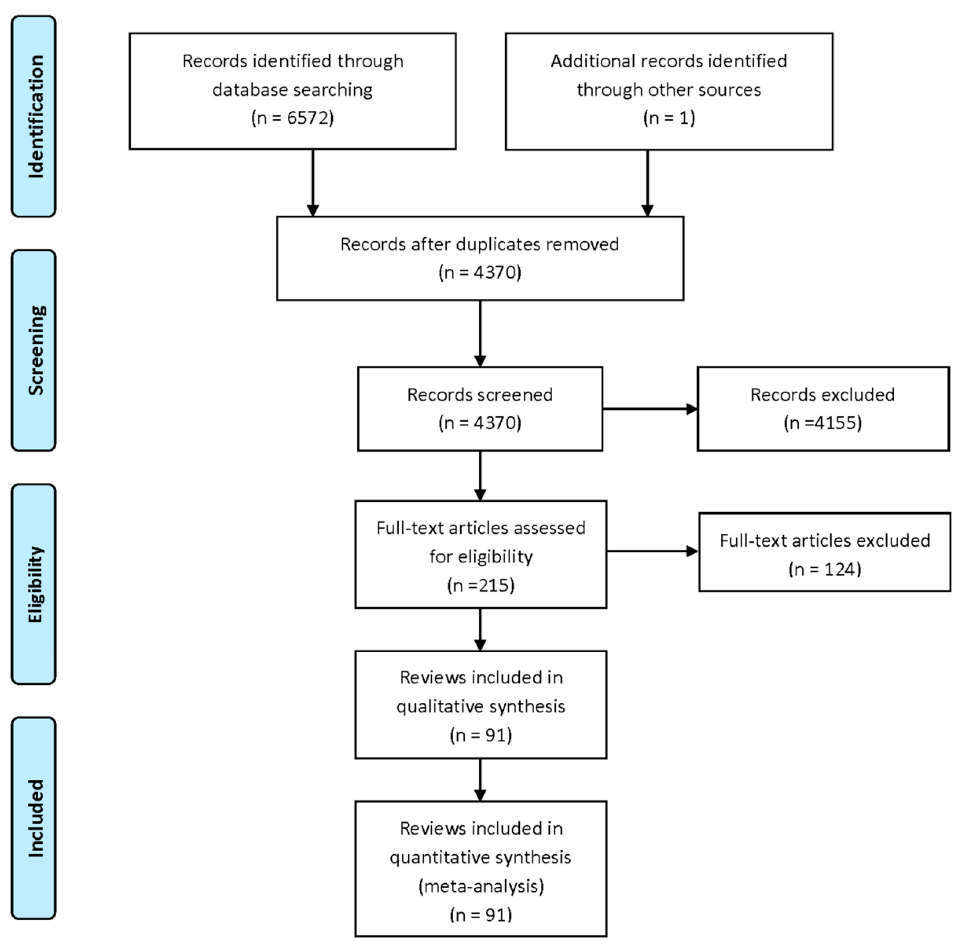
Figure 1. PRISMA flow diagram.